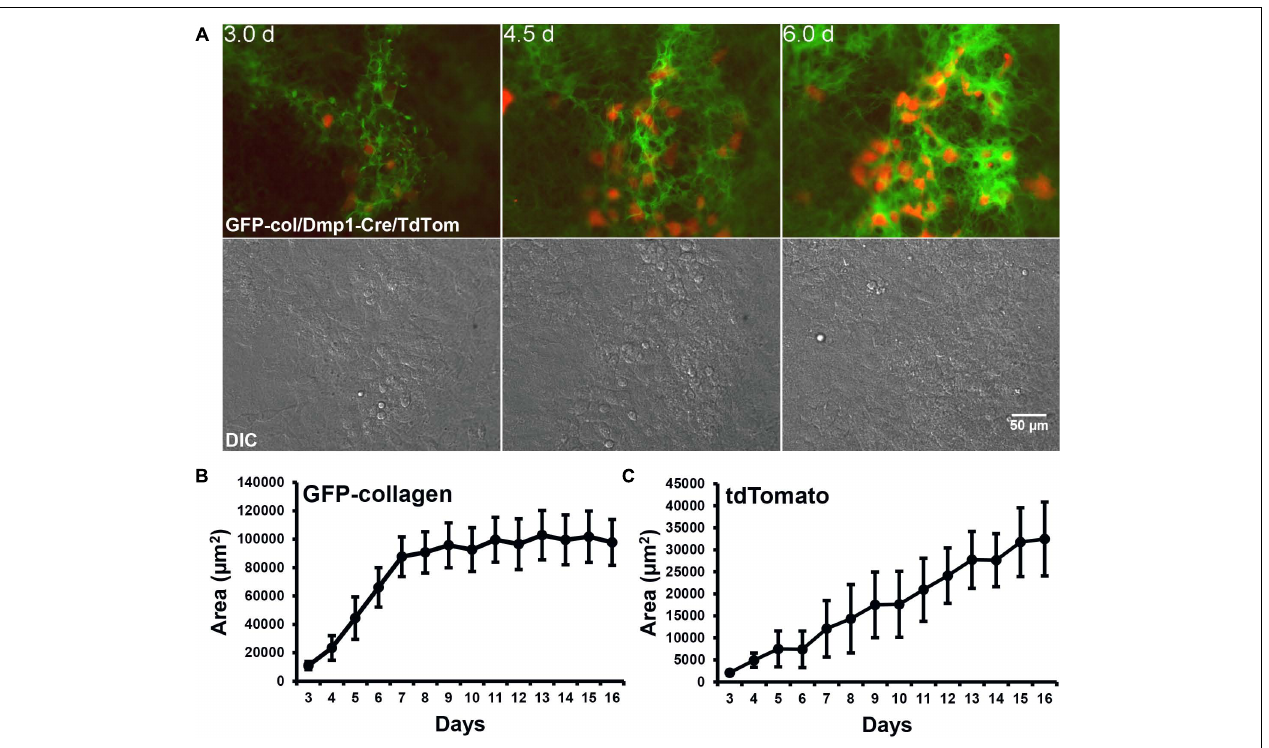
FIGURE 4 | Dmp1-Cre/tdTomato cell dynamics during collagen assembly. (A) Still frames from timelapse dual imaging of GFP-collagen (green) and Dmp1-Cre/tdTomato (red) in primary calvarial osteoblast cultures between days 3 and 6 (upper panels). DIC images of the cell cultures are shown in the lower panels. Bar = 50 µ m. To appreciate the dynamic process of collagen assembly together with tdTomato cell dynamics please view Supplementary Movie 9 . (B,C) Quantitative analysis of the area of GFP-collagen (B) and area of tdTomato-positive cells (C) in long-term osteogenic calvarial cell cultures over days 3–17. Data are mean ± SEM from n = 4 independent